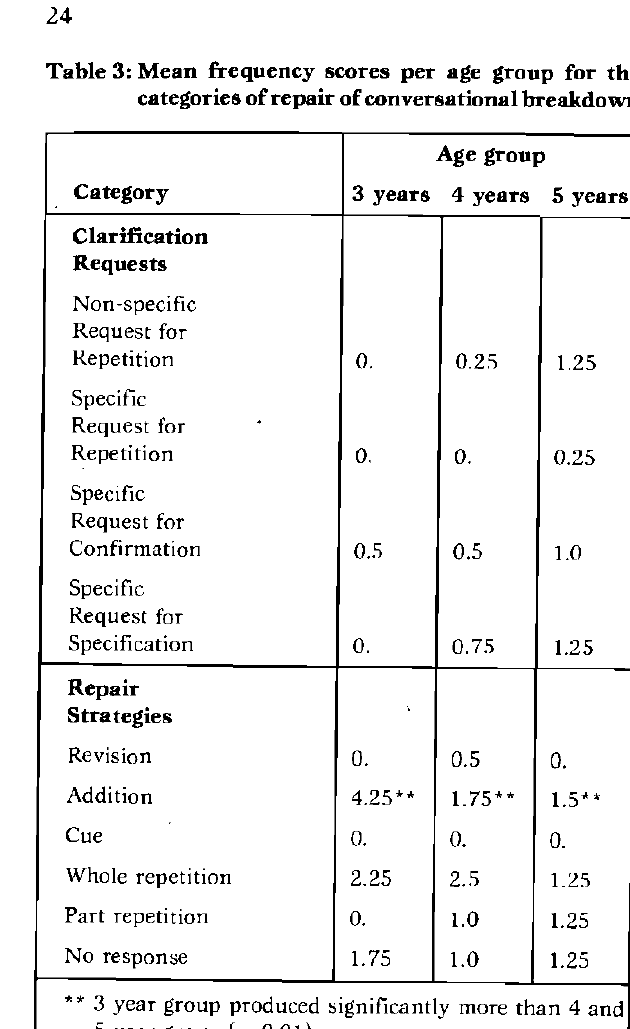
Table 3: Mean frequency scores per age group for